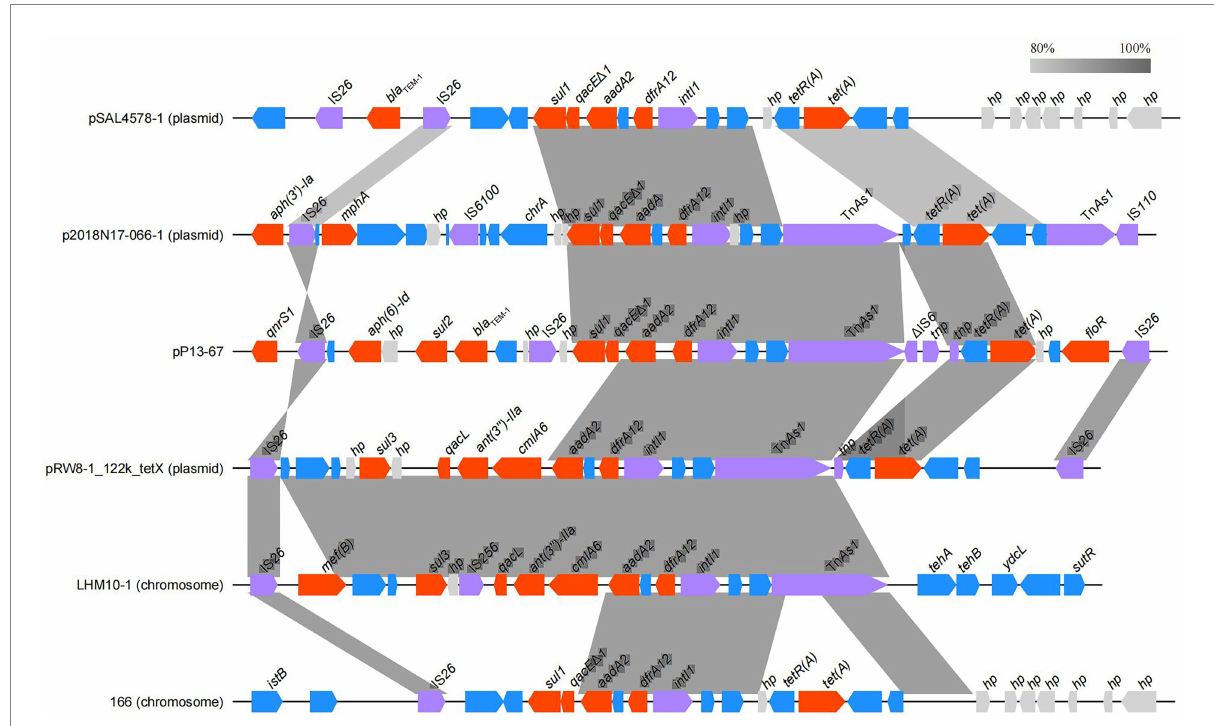
FIGURE 5 Comparison of the MDR region of pP13-67 with the related sequences on the other plasmids and chromosomes. Genes are denoted by arrows and colored according to gene function classification. Shading indicates the homologous